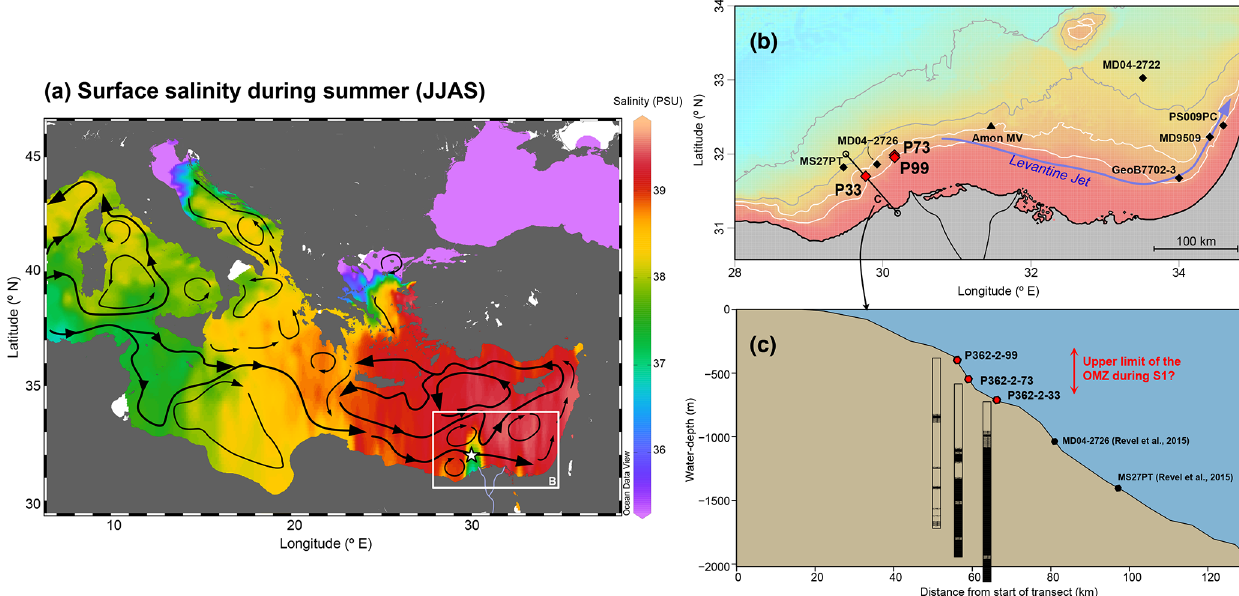
Figure 1. Regional context and location of the cores. (a) Sea-surface salinity during the summer months (June to September) (MedAtlas, MEDAR Group, 2002) plotted with the Ocean Data View software (Schlitzer, 2018). White star: location of the Nile River freshwater plume. Black arrows: surface currents (Pinardi et al., 2015; Rohling et al., 2015). (b) Zoom on the western Nile deep-sea fan (DSF), with locations of cores P33, P73 and P99 (this study), as well as neighbouring cores MS27PT and MD04-2726 (Revel et al., 2015), MD04-2722 (Tachikawa et al., 2015), GeoB7702-3 (Castañeda et al., 2010), PS009PC (Hennekam et al., 2014), MD9509 (Matthews et al., 2017) (black diamonds), and the Amon mud volcano (black triangle). White contours: 500 and 1000m isobaths; grey contours: 1500 and 2000m isobaths. (c) Bathymetric transect across the western Nile DSF with sediment lithological features (black: laminations; stripes: faint laminations). Map and bathymetric transect in (a) and (b) plotted using the R freeware (R Core Team, 2013), the marmap package (Pante and Simon-Bouhet, 2013) and gridded bathymetric data from Gebco (Gebco team,